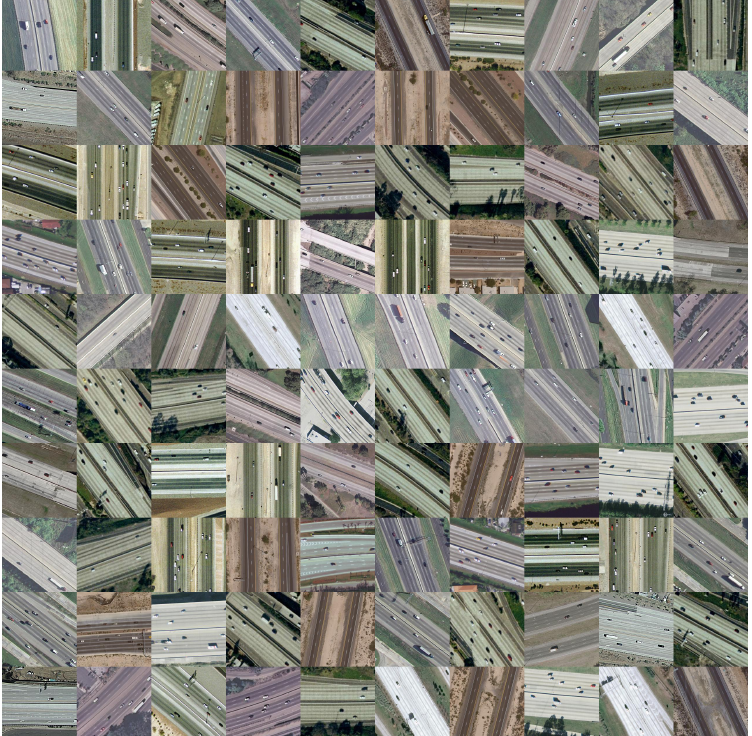
Figure A1. Ground truth for remote sensing images of freeway. There are 100 images of freeway in total.